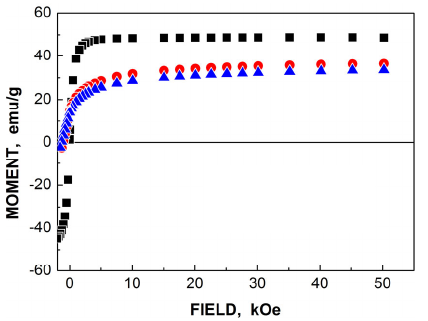
Figure 56. Isothermal magnetization curves measured at 295 K for NiFe 2 O 4 samples: N1 ( ■ ), N2 ( • ) and N3 ( ▲ ). Adapted from Ref. [83] with permission from Springer Nature: Hyperfine Interactions, “The milling effect on nickel ferrite particles studied using magnetization measurements and Mössbauer spectroscopy”, Ushakov M.V., Oshtrakh M.I., Chukin A.V., Šepelák V., Felner I., Semionkin V.A., ©2018.